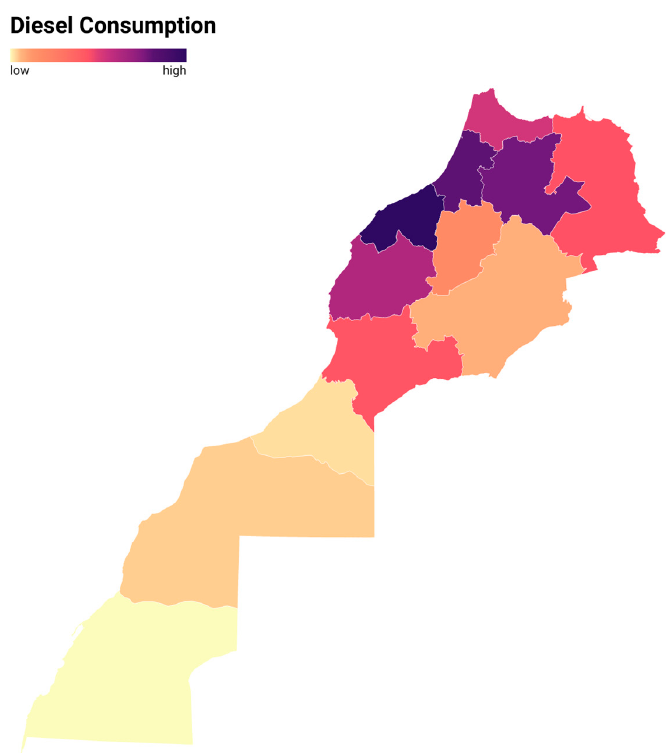
Figure 6. Choropleth Map of Diesel Consumption in Morocco.